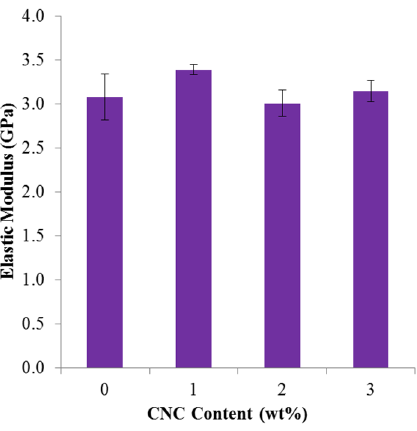
Figure 7. Elastic modulus of CNC/PLA films as a function of CNC content.